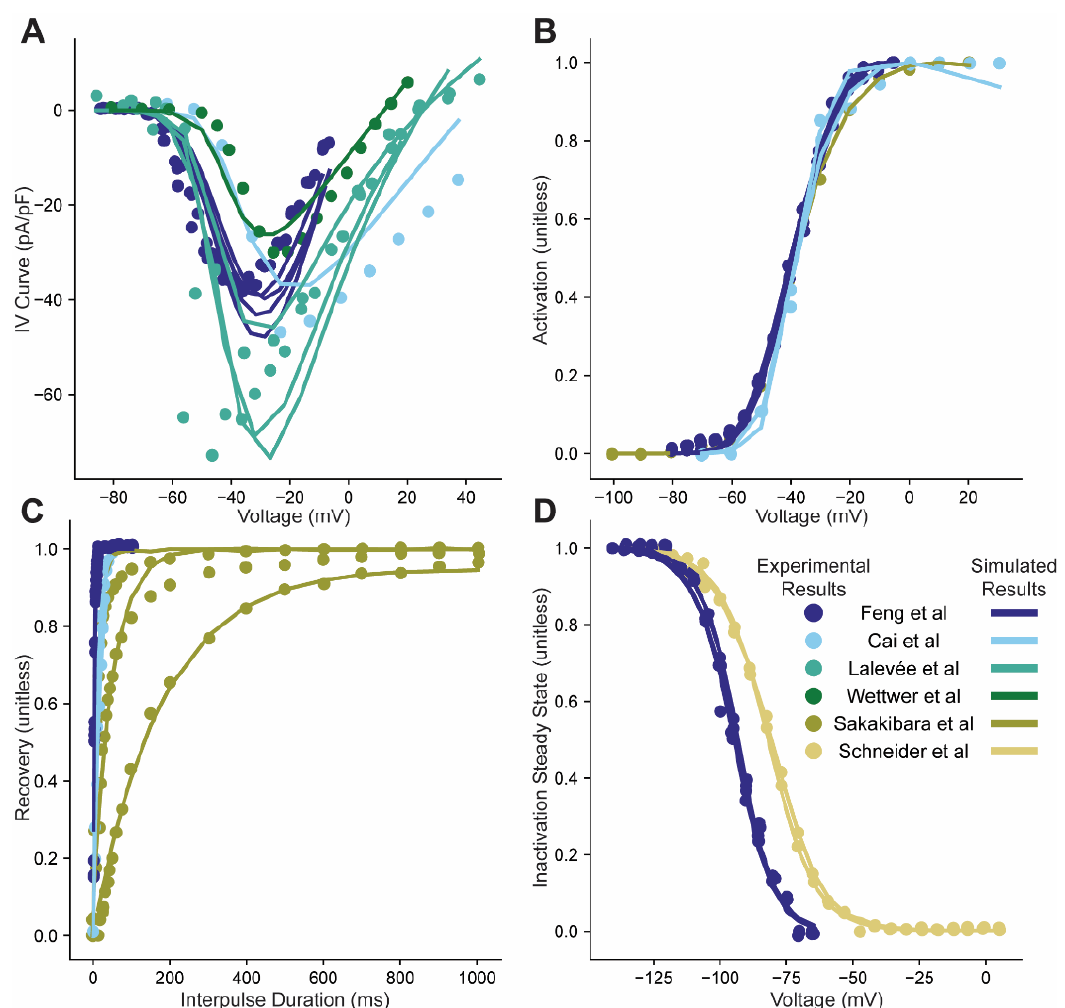
Figure 3. Simulated results of individual model fits to specific experiments. ( A – D ). Current Voltage relations, steady-state activation, recovery from inactivation, and steady-state inactivation curves using a different set of fit model parameters predicted by the statistical model (solid lines) for each experiment (circles). Data from Feng et al. had 4 experimental groups which were the lengths of time the cells were kept before an experiment was performed: 0, 1, 3, 5 days; Cai et al. had two experimental groups: cells taken from adult or pediatric patients; 3 control IV curve experiments were taken from Lalev é e et al.; Wettwer et al. had a single IV curve control experiment; Sakakibara et al. had one control activation curve and three recovery curves with different inter-pulse holding potentials: − 100, − 120, − 140 mV; and two inactivation curve experiments were taken from Schneider et al. with different durations for the inactivation potential: 512 and 256 ms [33–38]. Data from different experiments taken from the same paper are indicated with a single color indicated in the legend (same for corresponding simulation